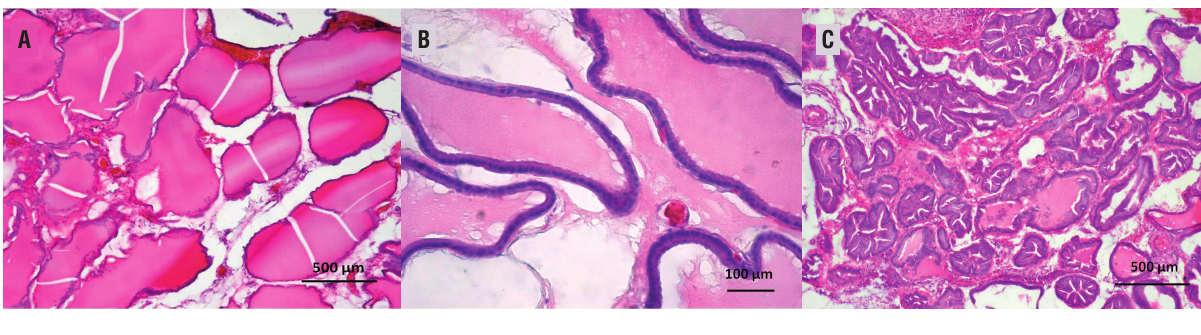
figure 2 - A) normal prostate tissue. Regular acinus forms, homogeneous lumen secretion and connective tissue density. hematoxylin-eosin (hE) stain, magnification 200X. scale Bar: 500μm.; B) The acini were surrounded with a thin stroma and the base membrane was thin and uninterrupted. hematoxylin-eosin (hE) stain, magnification 400X. scale Bar: 100μm.; c) hyperplastic prostate tissue. columnar and overly curved acinus epithelium, irregular acinus and fibrotic connective tissue. hematoxylin-eosin (hE) stain, magnification 200X. scale Bar: